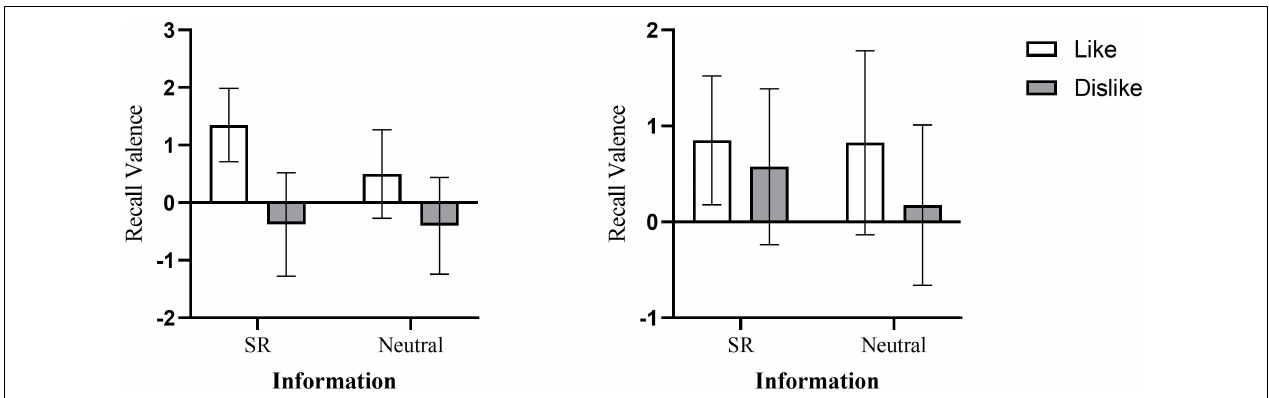
FIGURE 3 | Recall valence as a function of the audience’s attitude and the information under high relational motivation condition ( left panel ) and under low relational motivation condition ( right panel ) (bars represent 95% confidence intervals).